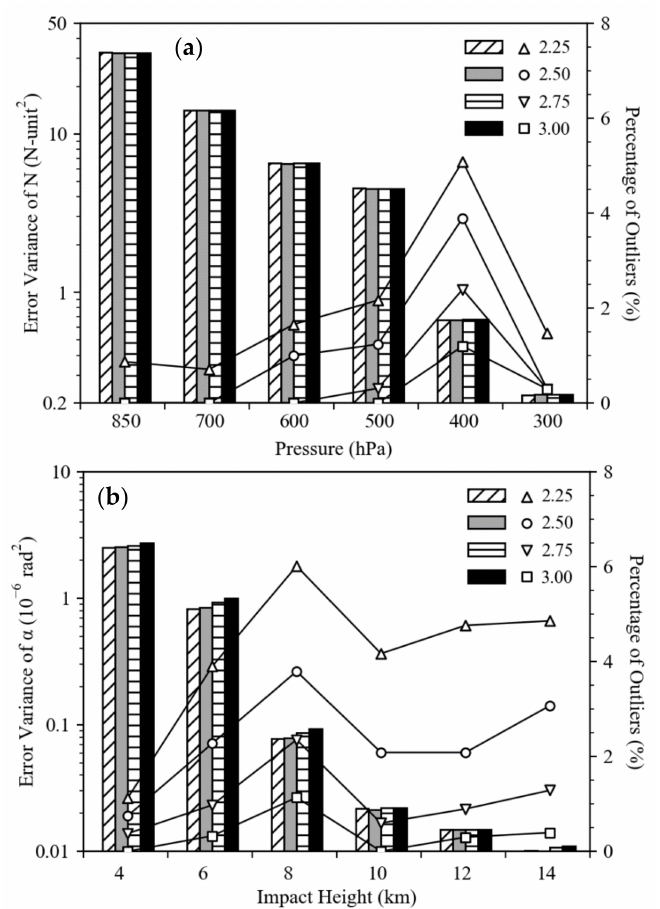
Figure 2. The error variances (left x-axis) of ( a ) RO refractivity at 850 hPa, 700 hPa, 600 hPa, 500 hPa, 400 hPa, and 300 hPa and ( b ) bending angle at the 4 km 6 km, 8 km, 10 km, 12 km, and 14 km impact heights, along with the percentage (right x-axis) of removed data during quality control, using 4 thresh- olds for Z-scores (2.25, 2.50, 2.75, and 3.00) at the Shanghai radiosonde station (31.4 ◦ N, 121.5 ◦ E). A total of 390 RO profiles were collocated at this